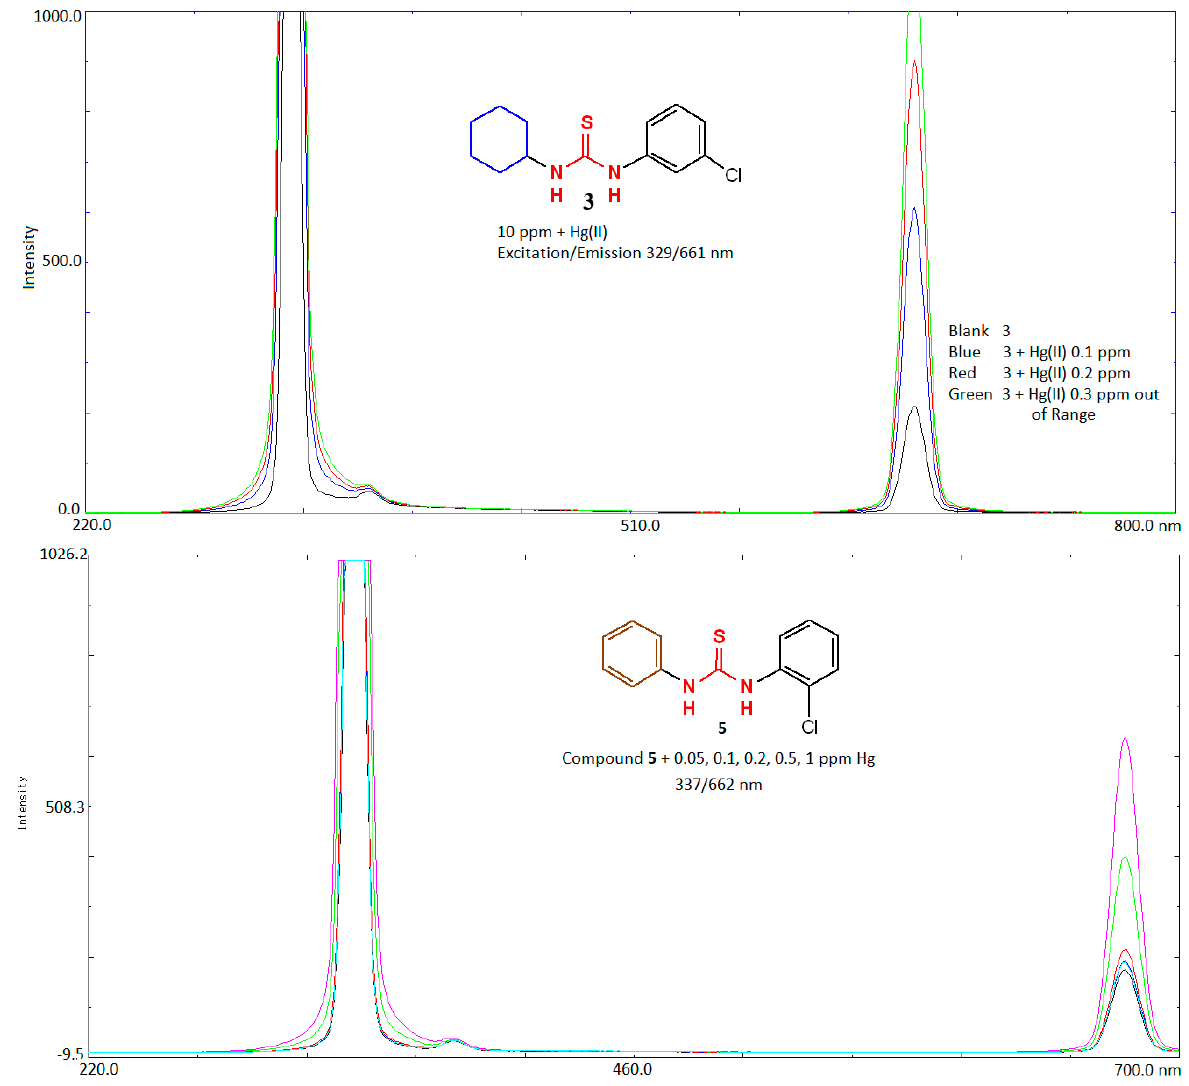
Figure 8. Representative fluorescence spectra of 3 and 5 as a function of concentration of Hg(II) ion.